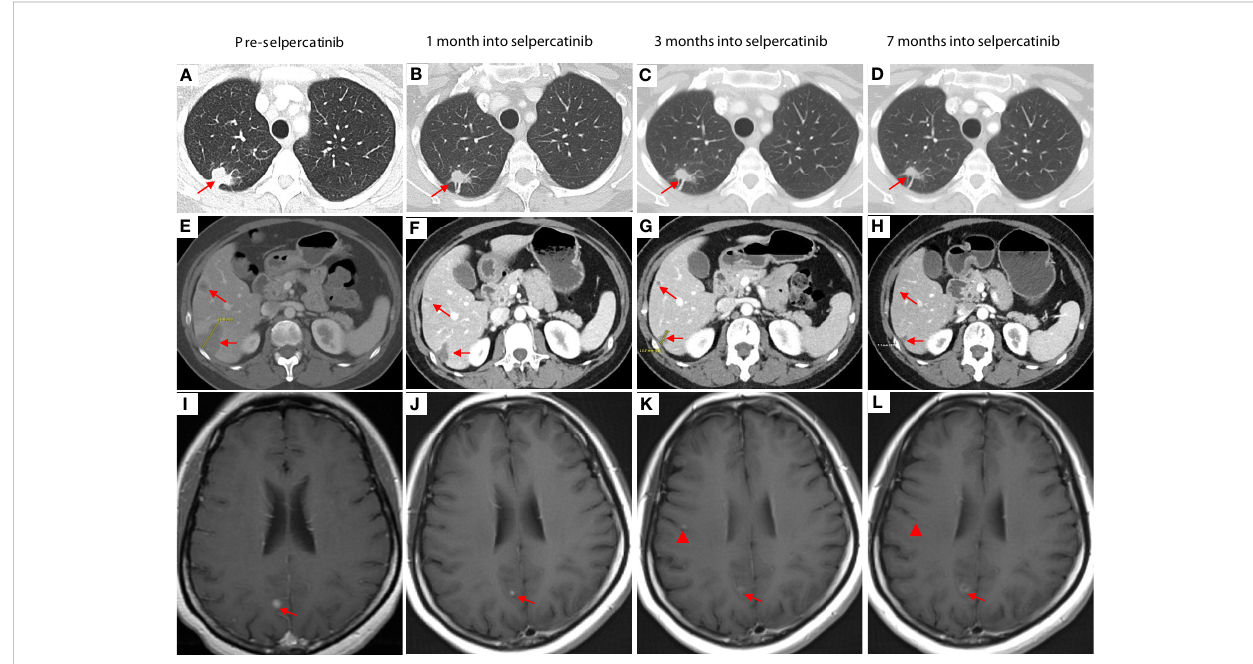
FIGURE 2 Pretreatment images were obtained 3 weeks prior to the initiation of chemotherapy. The images in the second column were taken 1 month after the start of selpercatinib treatment (3 weeks after the fi rst day of the second cycle of chemotherapy). CT images show shrinkage of lesions in the right upper lobe (A – D) and in the liver (E – H) . Brain lesions responded to selpercatinib [ (I – L) , arrows] except for the development of tiny new brain lesions when the patient was on a low dose of selpercatinib 40 mg twice daily [ (K) , arrowhead], which have improved [ (L) , arrowhead] or remained stable with subsequent increases in dose of selpercatinib. At 7 months, the patient was receiving a dose of 120 mg of selpercatinib in the morning and 80 mg in the